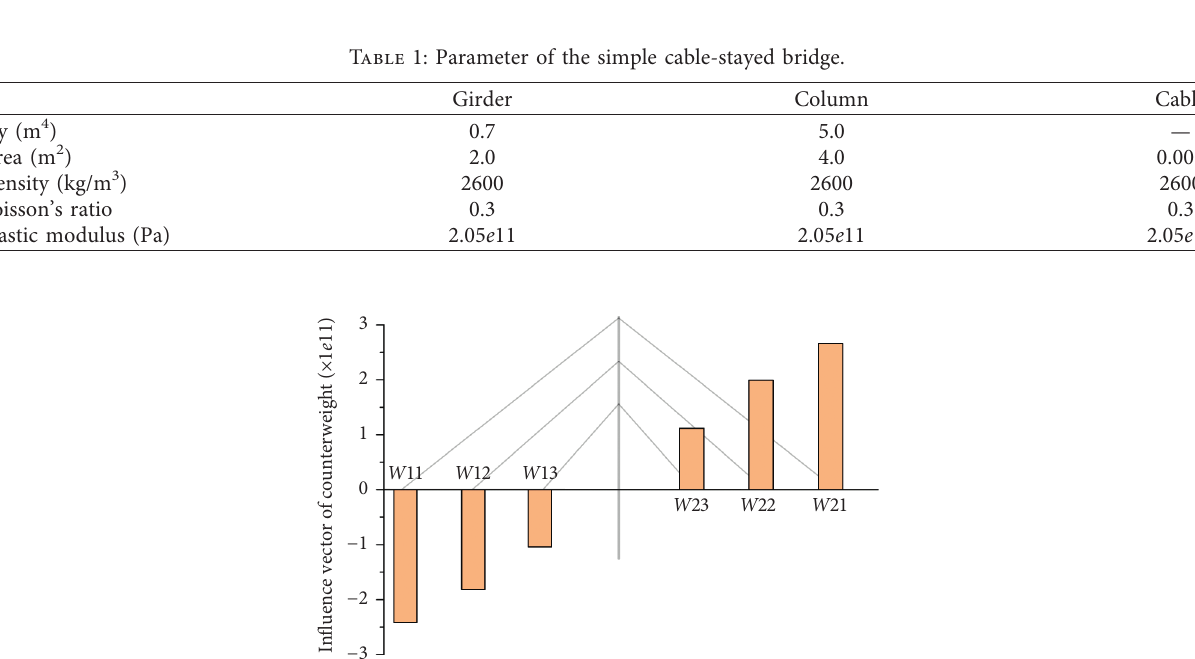
Figure 5: Influence vector of counterweight on primary objective function.